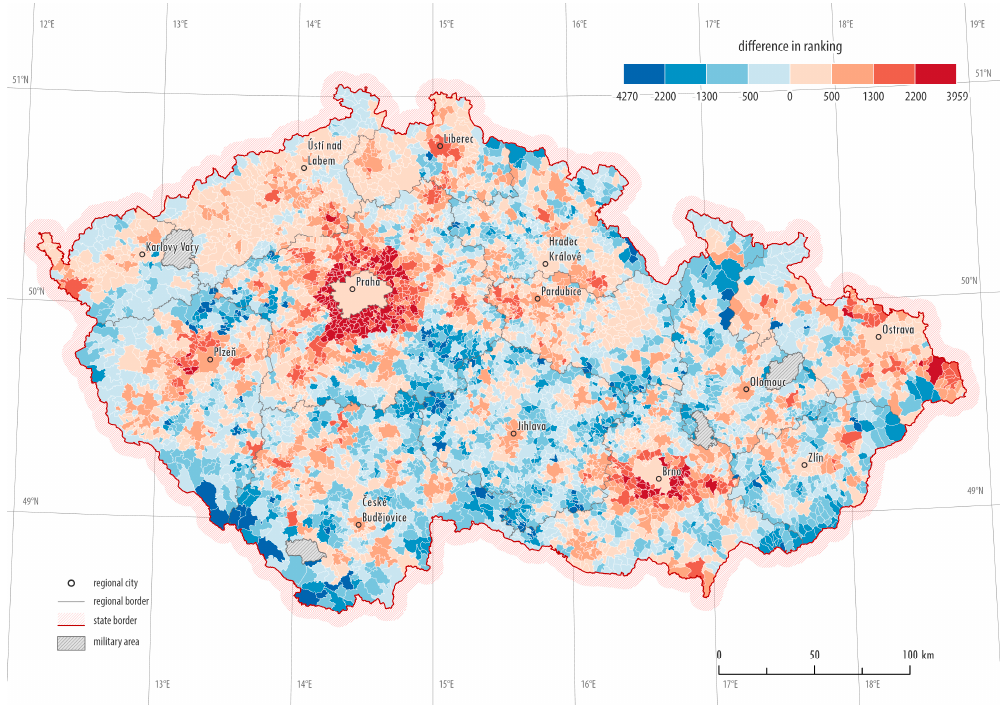
Figure 4. Difference in the ranking of individual municipalities.